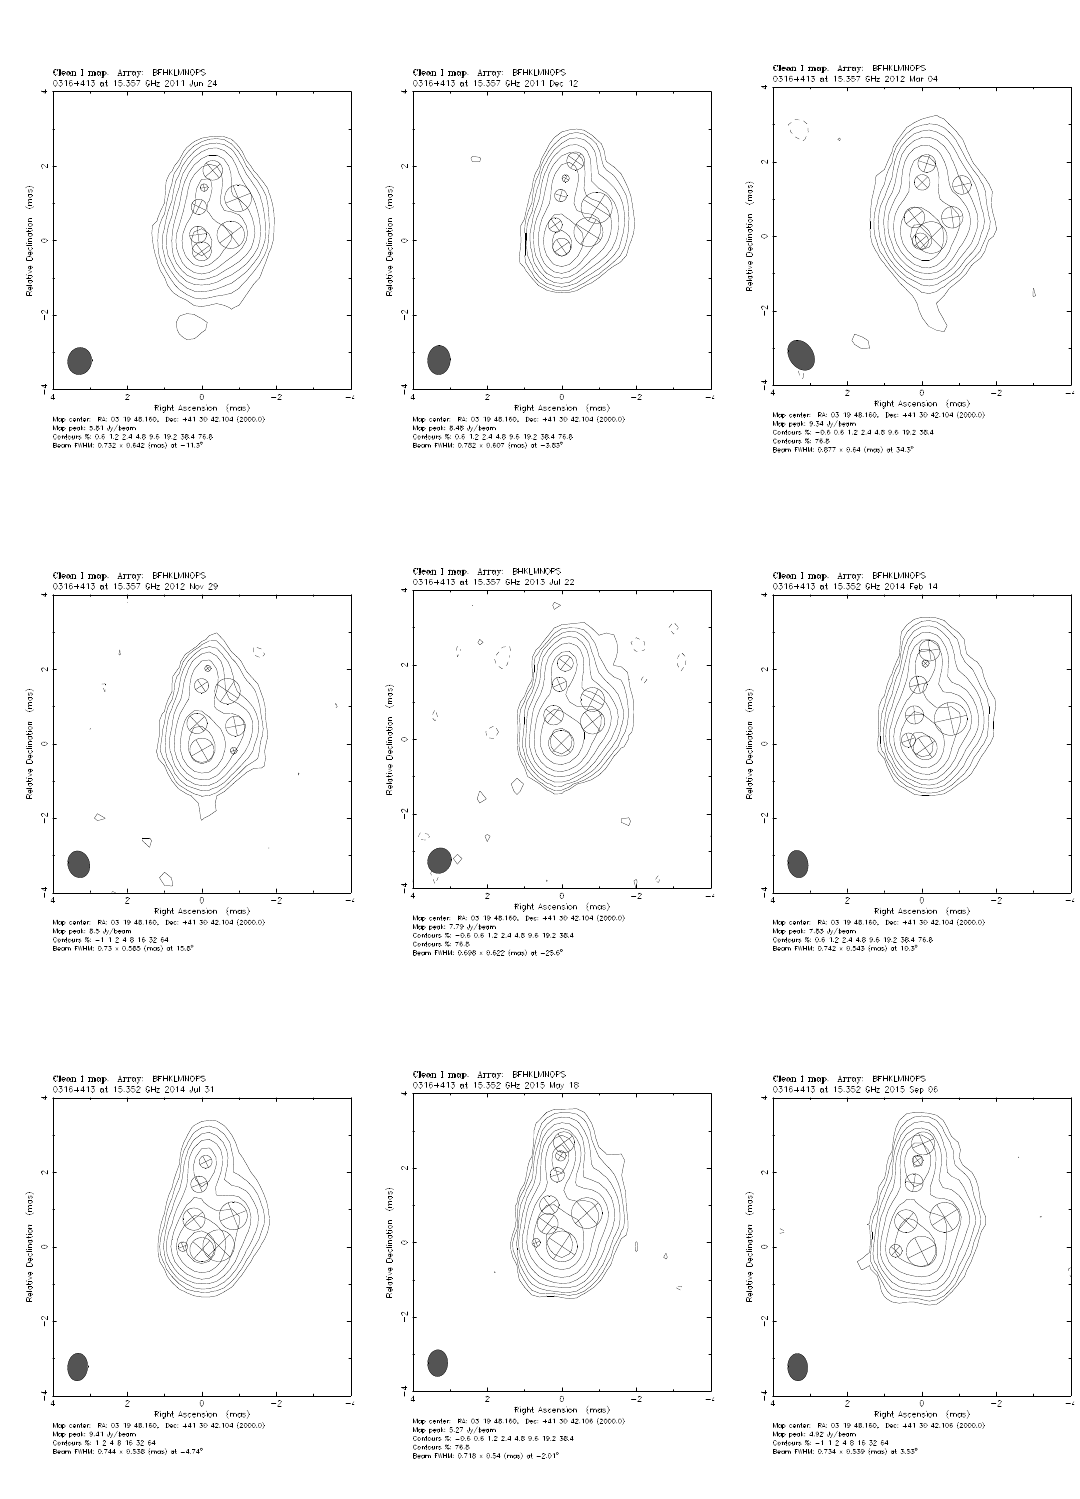
Figure A4. Same as Figures A1–A3 for epochs: June 2011—September